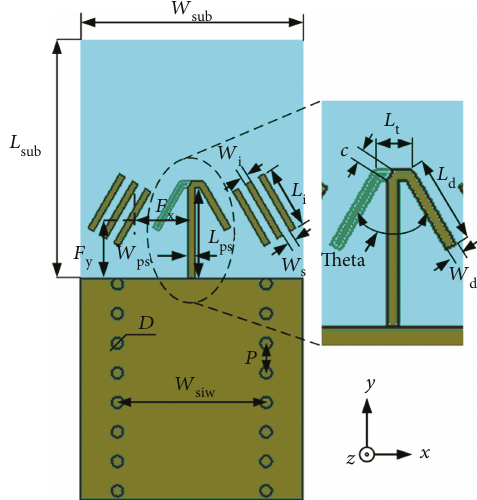
Figure 6: A mm-wave planar antenna with an end- fi re radiation pattern in both E and H planes